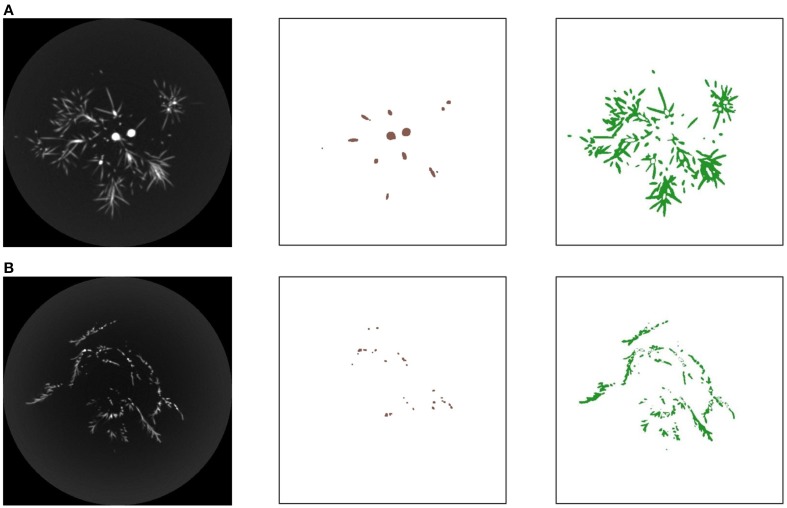
(A) From left to right, one of the 428 gray-tone CT images (thickness: 0.4 mm) constructed for the crown of the miniature coniferous tree (Picea abies Tompa) in Figure 1A; the branch part delineated from the corresponding 512 × 512 matrix of CT numbers, colored in brown; and the leaf part obtained by subtraction (excluding air) and colored in green. (B) Similar information for the miniature coniferous tree (Microbiota decussata Gold Spot) depicted in part in Figure 1B; the gray-tone CT image displayed is one out of 450 with thickness of 0.3 mm used to analyze the crown in this case. Note: The two skeletal branching patterns are contained in 400 and 438 CT images, respectively.